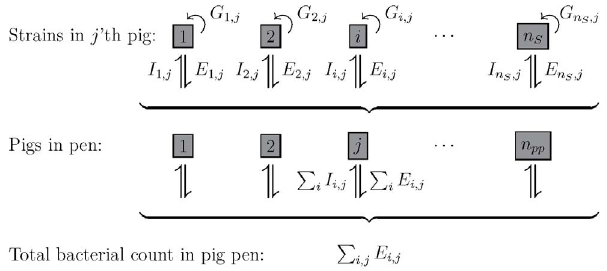
Figure 1. The model structure. For each pig the growth, G , excretion, E , and intake, I , of n S unique bacterial strains are modeled. Excreted bacterial material is summed up pen-wise, and a fraction will be taken back in by the n pp pigs sharing the pen. Excretion is driven by the excretion rate, Q ; while transmission is described by the uptake fraction from the environment, j ; furthermore, bacterial strains in amounts below a cutoff value, g , in each individual pig have a probability of being